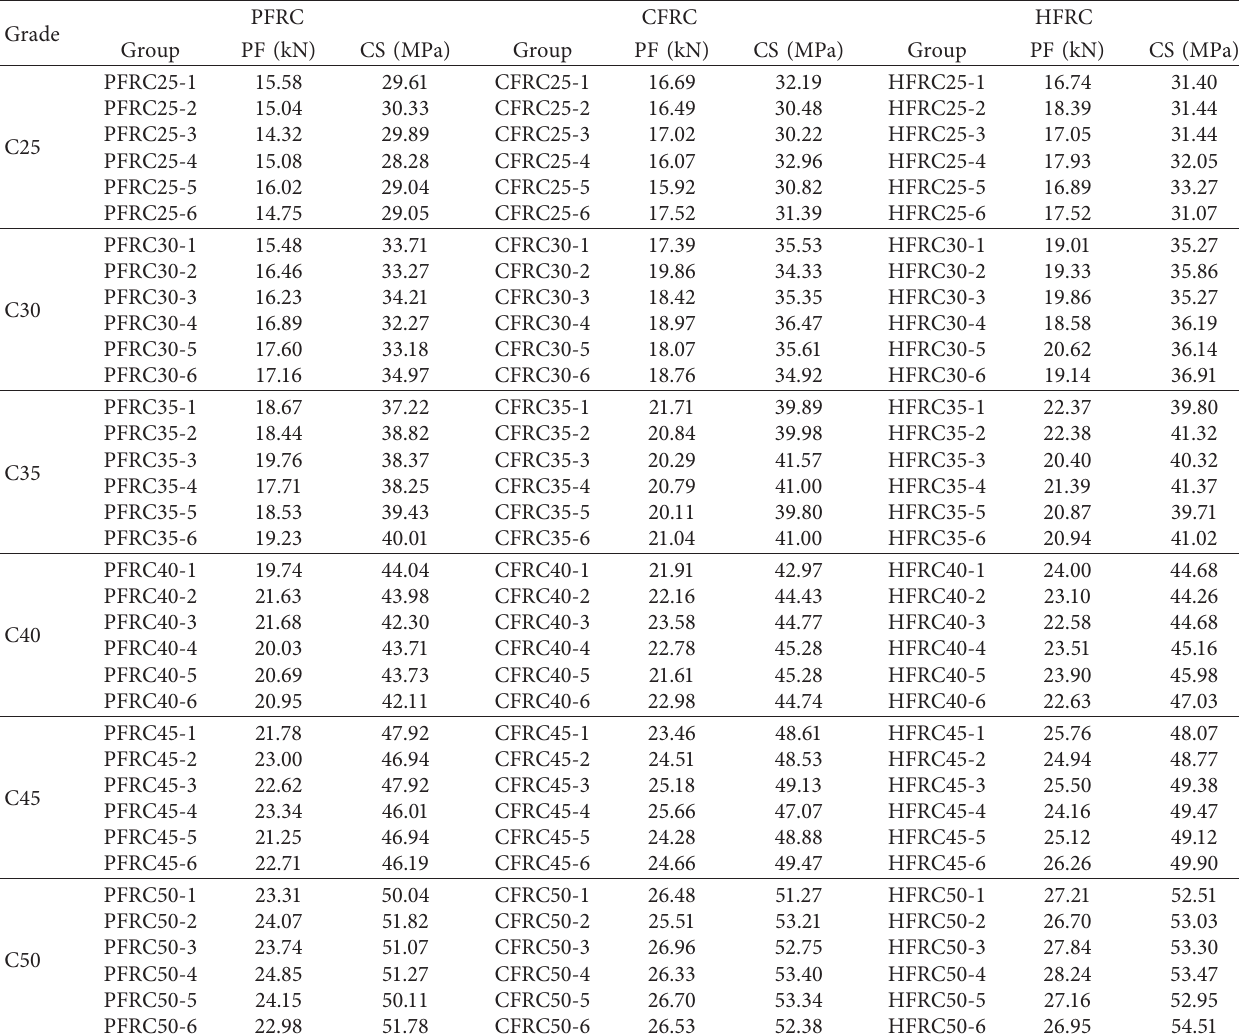
Table 5: Summary of postinstalled pull-out test